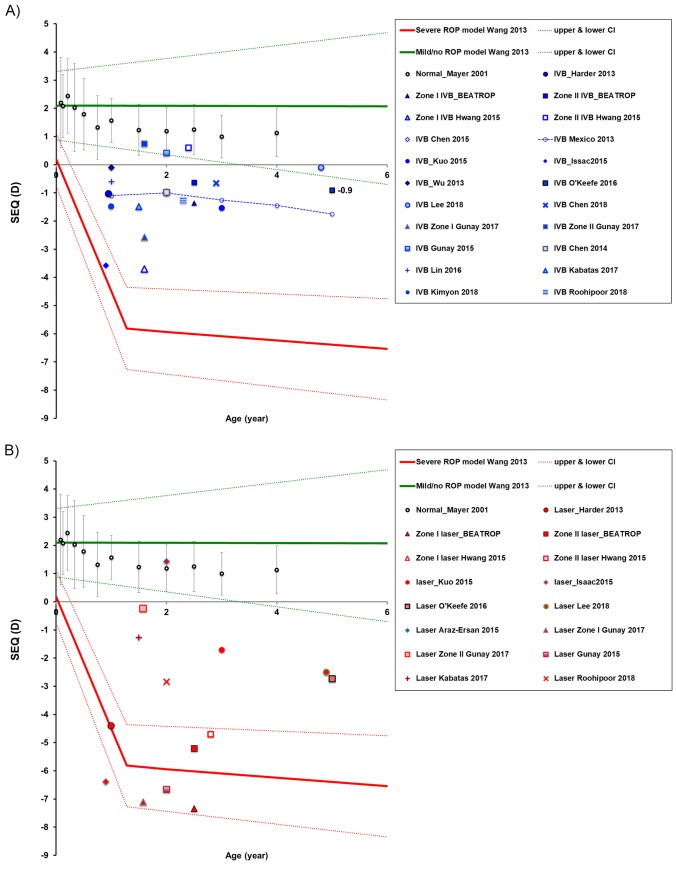
SEQ as a function of age summarized in literature.A) Data from post IVB children. B) Data from the post-laser children. The blue fill color is IVB treatment related, while the red fill color is laser treatment related. The black round circles showed the normal full term population [48]. When information related to Zone I and Zone II, the triangle symbol is for Zone I; the square symbol is for Zone II. The blue symbols with dashed line showed the only longitudinal IVB study from Mexico colleagues [16]. Note: Standard deviations and ranges are not plotted on the figure because standard deviation ranges are generally significantly larger for IVB treated children than the normal population.